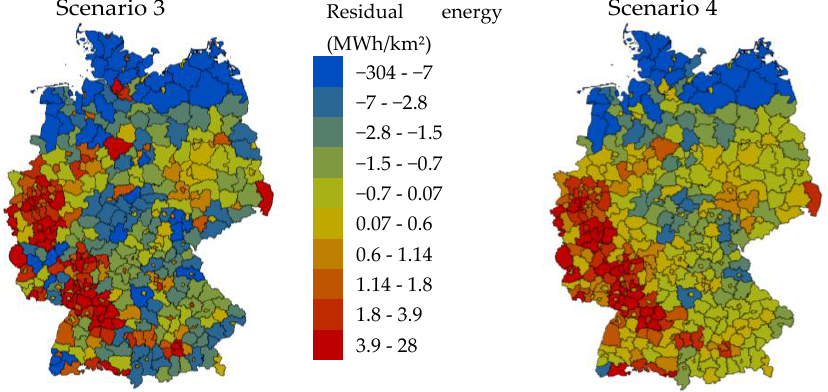
Figure 12. Result of the residual load analysis: before grid dynamics are included ( left ); and after grid dynamics are included ( right ), on the county level. The blue indicates regions with a negative residual load, meaning that they have excess energy to lend. These regions are most heavily clustered in the north of Germany, where wind potential is greatest. Red indicates regions with a positive residual load.